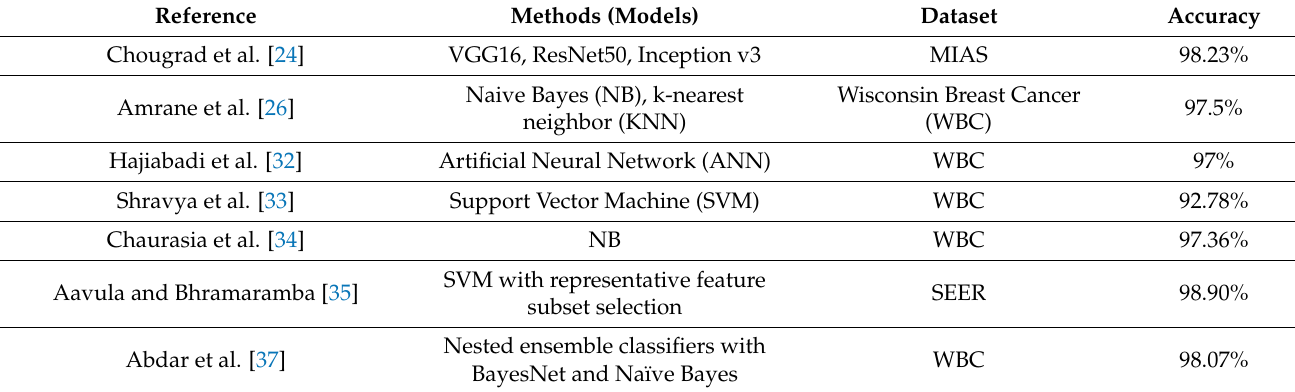
Table 1. Summary of related